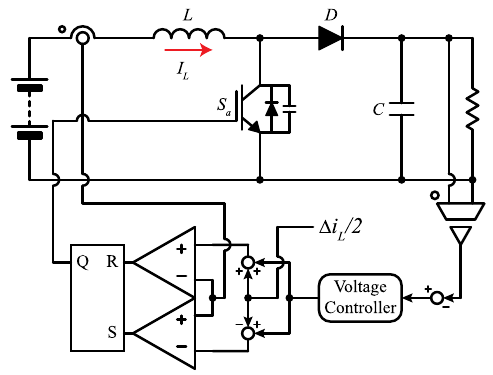
Figure 9. Control block diagram of hybrid current-mode boost converter.